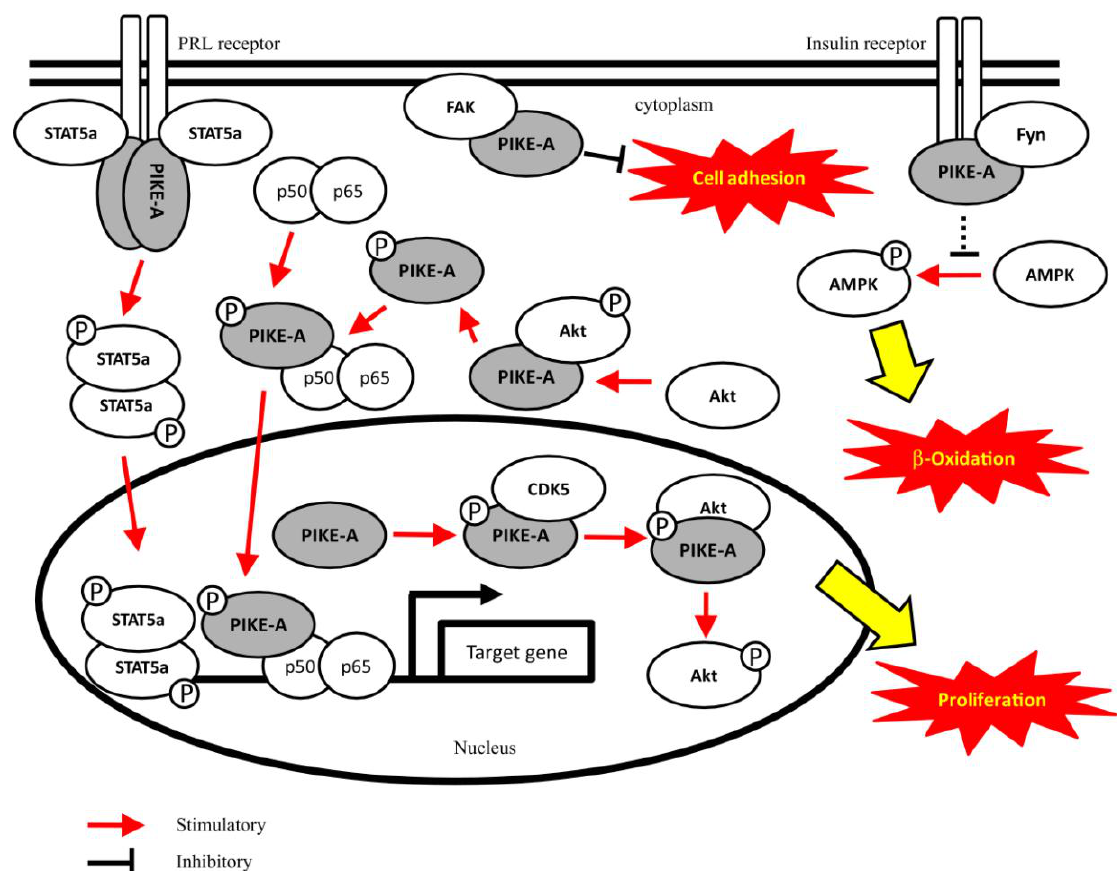
FIGURE 2. Summary of PIKE-A function in various physiological